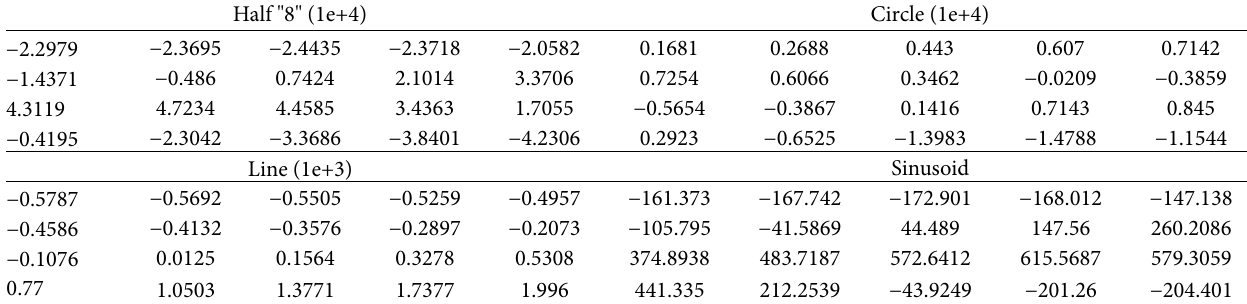
Table 1: The weights of force function.